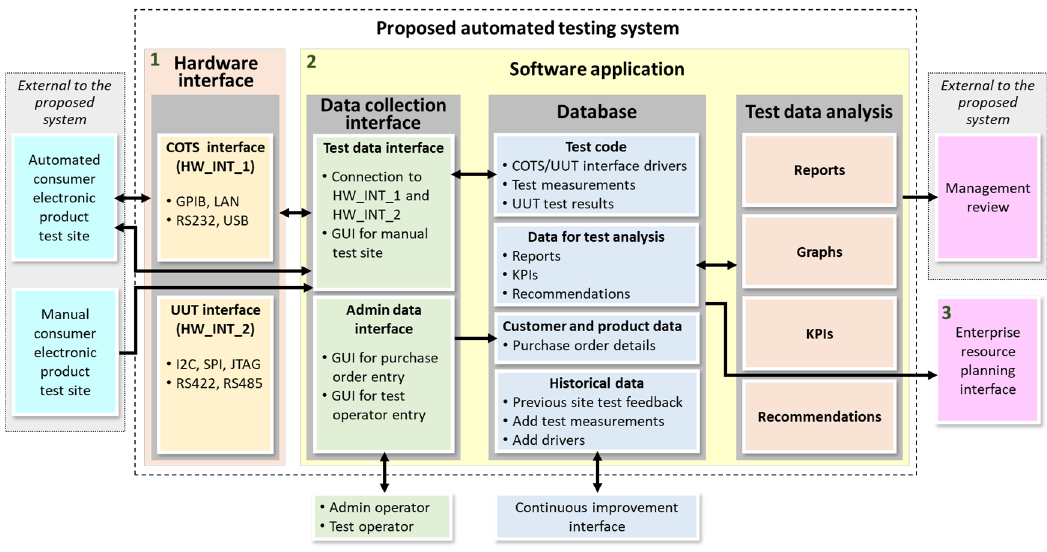
Figure 4. Proposed automated testing system block diagram.